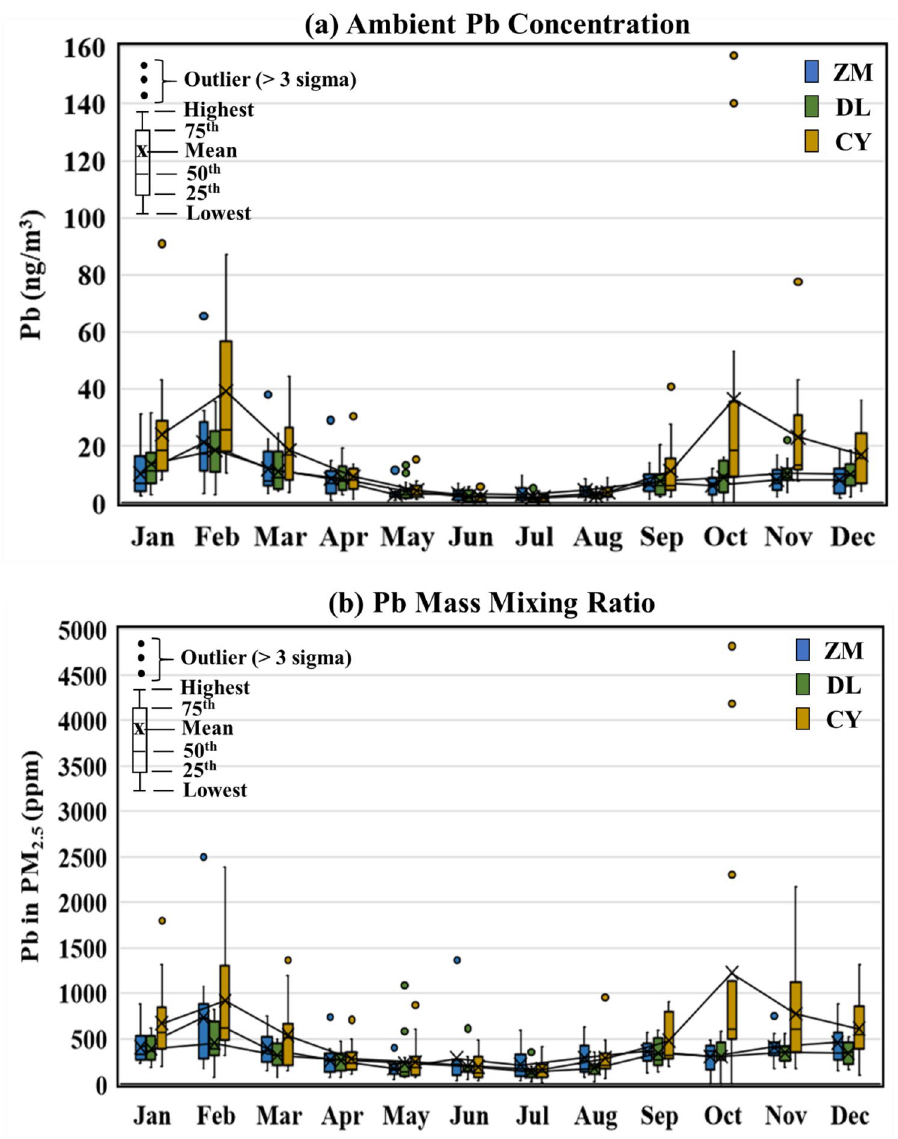
Figure 1. Seasonal variations in the ambient concentrations ( a ) and mass mixing ratios ( b ) of Pb in PM 2.5 . Samples are collected at the Zhongming (ZM), Douliu (DL), and Chiayi (CY) sites of the Taiwan EPA PM 2.5 speciation network from 2017–2019. Geographic information on the sampling sites is shown in Supplementary Fig.